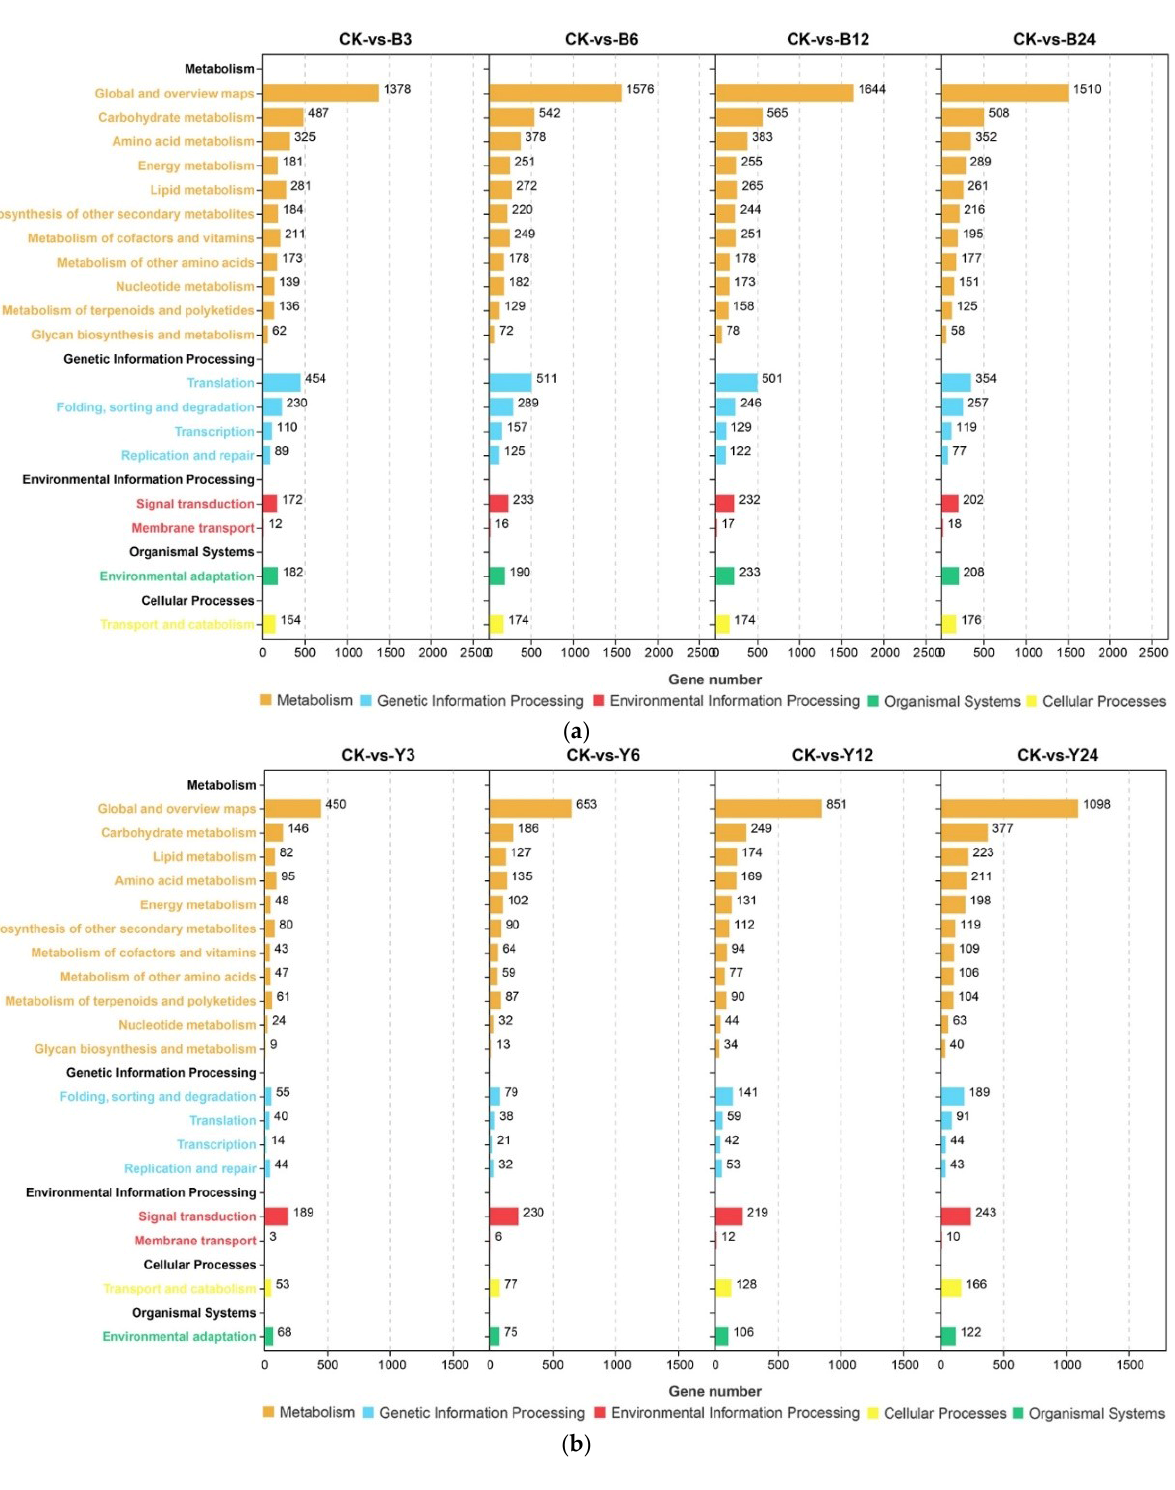
Figure 4. KEGG Ortholog database (KO) analysis. The vertical axis represents the entries of the pathways, and the horizontal axis represents the number of genes. Columns of the same color represent the same first class. B3 ‐ B24 means barnyardgrass was treated with florpyrauxifen ‐ benzoyl for 3, 6, 12, or 24 h. Y3 ‐ Y24 means yerbadetajo was treated with florpyrauxifen ‐ benzoyl for 3, 6, 12, or 24 h. ( a ). KO analysis for barnyardgrass after florpyrauxifen ‐ benzoyl treatment. ( b ). KO analysis for yerbadetajo after florpyrauxifen ‐ benzoyl treatment.